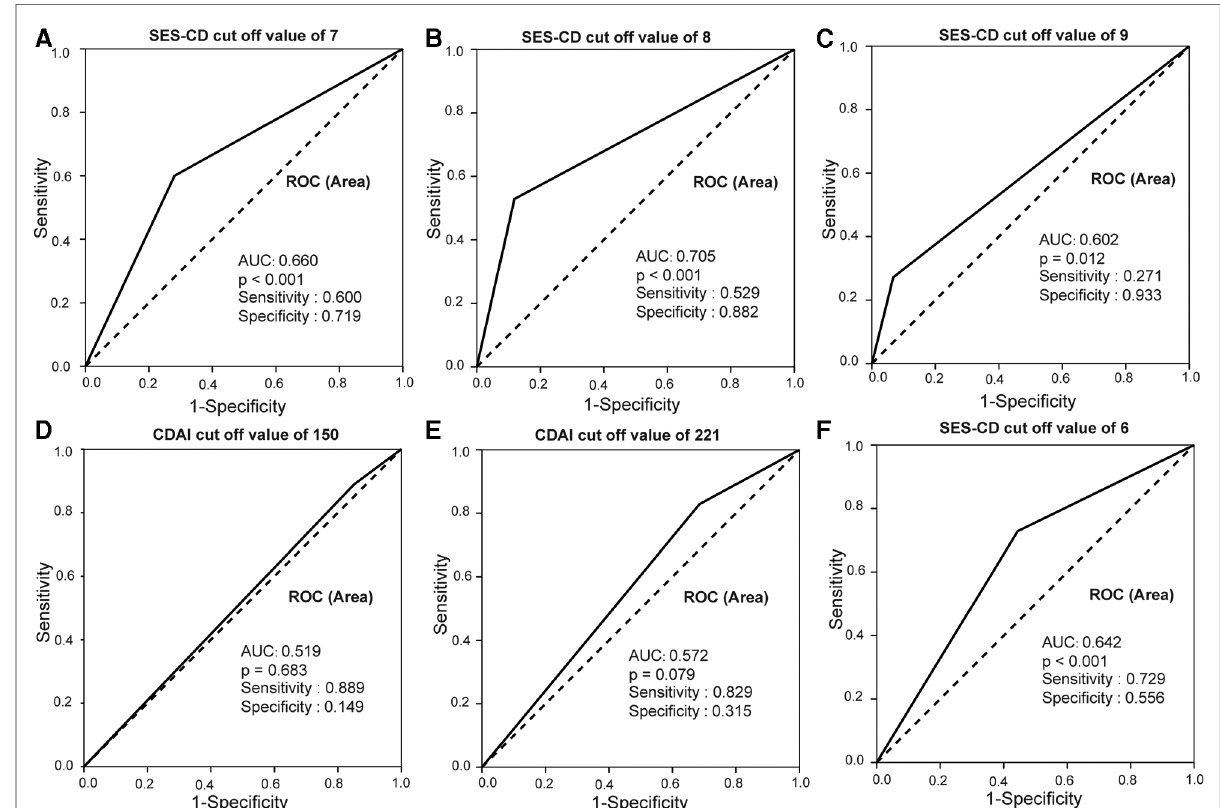
FIGURE 3 SES-CD and CDAI ROC curves in predicting intestinal obstruction in CD patients. ( A – C ) SES-CD ≥ 8 had the most signi fi cant AUC of 0.705 with a sensitivity of 52.9% and speci fi city of 88.2%. ( D – F ) CDAI ≥ 221 had the biggest area under AUC of 0.572 with a sensitivity of 82.9% and speci fi city of